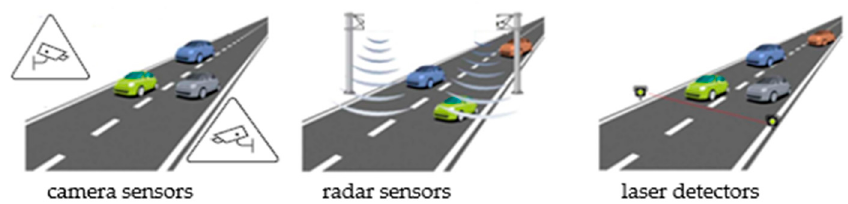
Figure 5. Non-intrusive sensors placed on the roadside at ground level or with a view of the road from above [40].